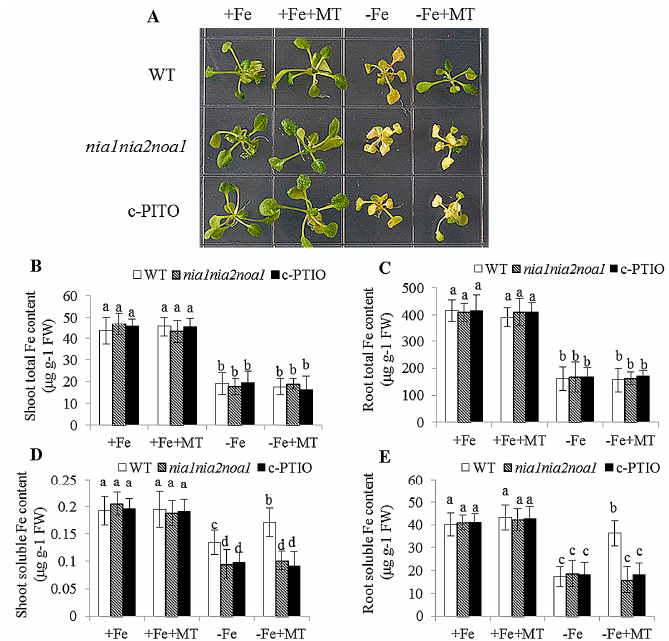
Figure 6. The effect of exogenous melatonin on Fe deficiency symptoms in the WT, nia1nia2noa1 , and c-PTIO-treated Arabidopsis plants. Seven-day-old seedlings were treated with or without 5 μ M melatonin in the presence or absence of 50 μ M Fe for 8 days. Then, these plants were used to analyze the growth phenotype ( A ), total Fe content of shoots ( B ) and roots ( C ), and soluble Fe content of shoots ( D ) and roots ( E ). Each bar is the mean ± SE of at least three replicates, and different lowercase letters above the bars indicate significant differences using Tukey’s test at p < 0.05.